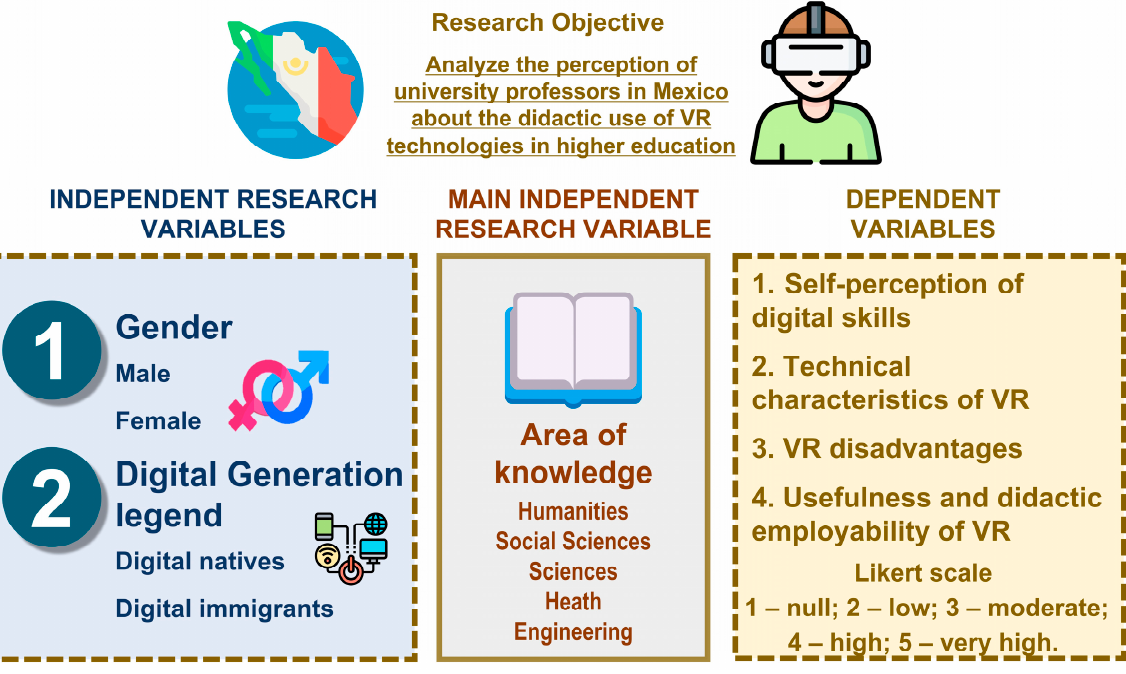
Figure 4. Research variables.